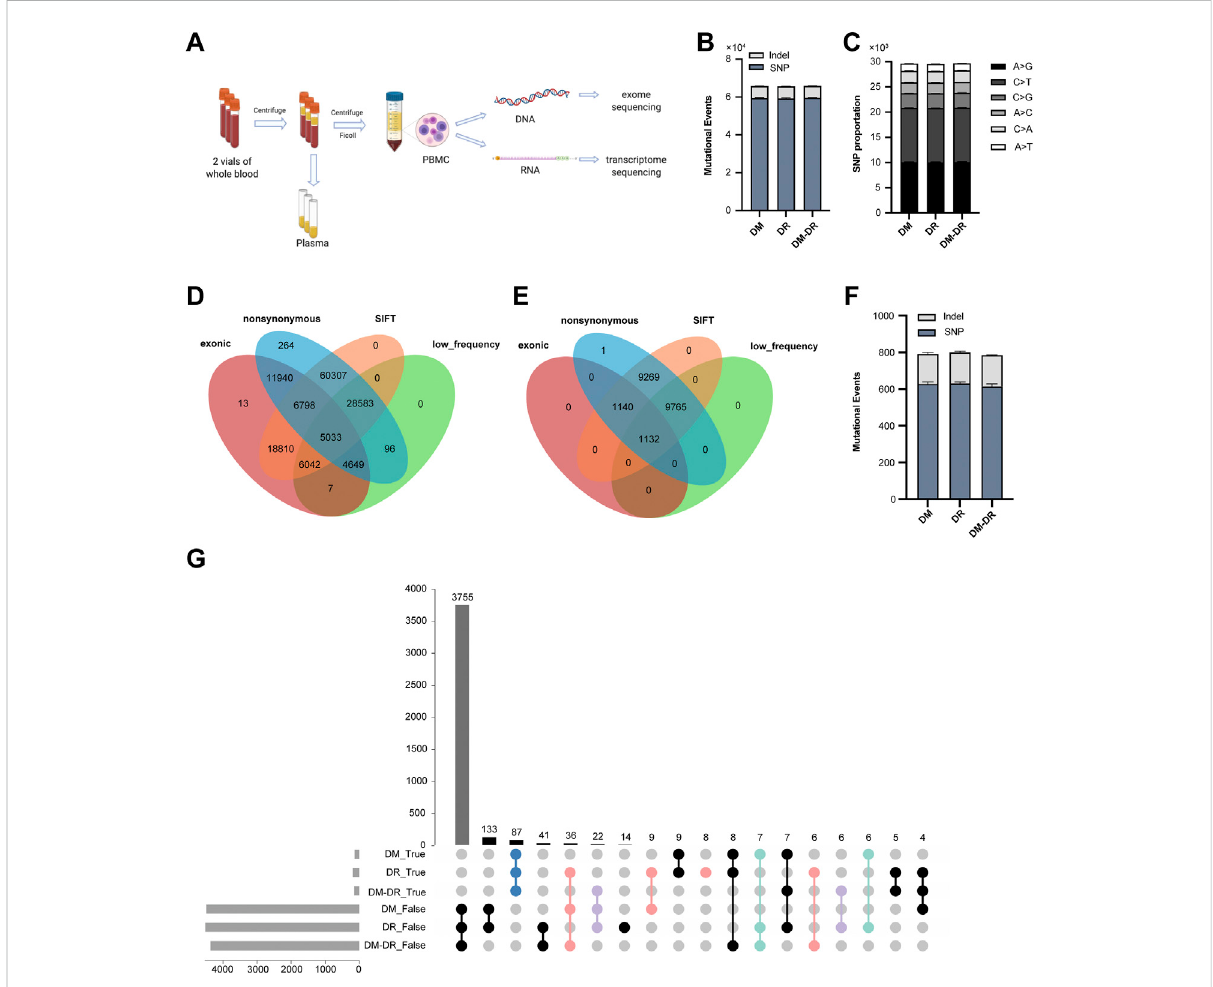
FIGURE 1 Exome-based pathogenic evaluation of patient peripheral blood mononuclear cells (PBMCs). (A) schematic diagram of sample processing. Peripheral blood samples were collected and plasma and PBMCs were separated. The DNA and RNA were isolated from PBMCs and processed for high-throughputRNAandDNAsequencing,respectively. (B) histogramofthenumbersofmutationaleventsineachgroup. (C) base-leveltransitions and transversions in each group shown in (B) . (D,E) Venn diagram for the comparison of number of single-nucleotide polymorphisms (D) and Indels (E) called between different mutation calling tools using the ANNOVAR software. (F) histogram of the numbers of pathogenic mutational events in each group. (G) UpSet plot showing the intersection of overlapped pathogenic variants across three groups. True represents mutation rate ≥ 60% and false represents mutation rate ≤